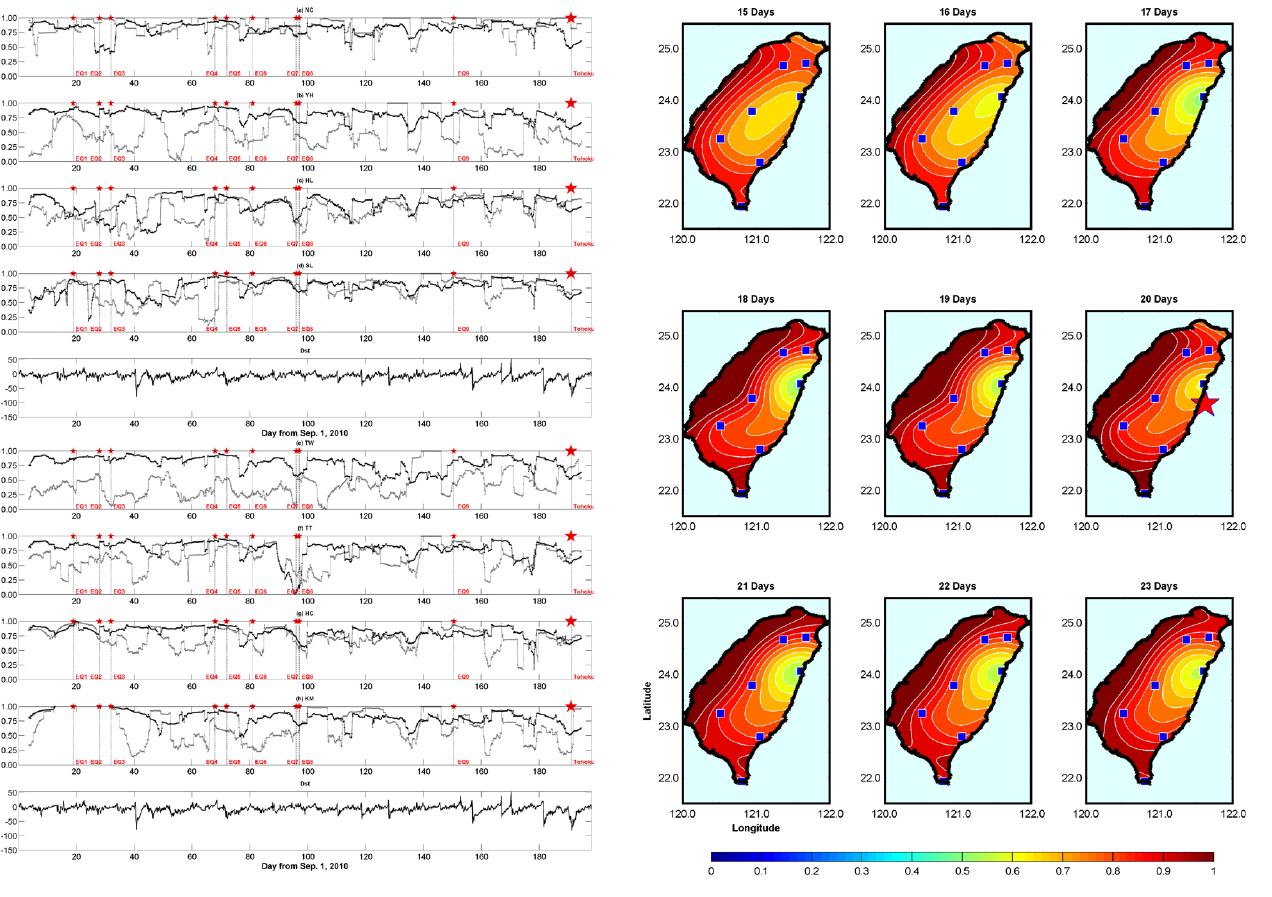
Fig. 5. A contour map of the cross correlation values from night- time data during EQ1. Blue squares indicate locations of the geo- magnetic stations in Taiwan. A red star represents the epicenter of EQ1. Color lines on Taiwan denote the cross correlation